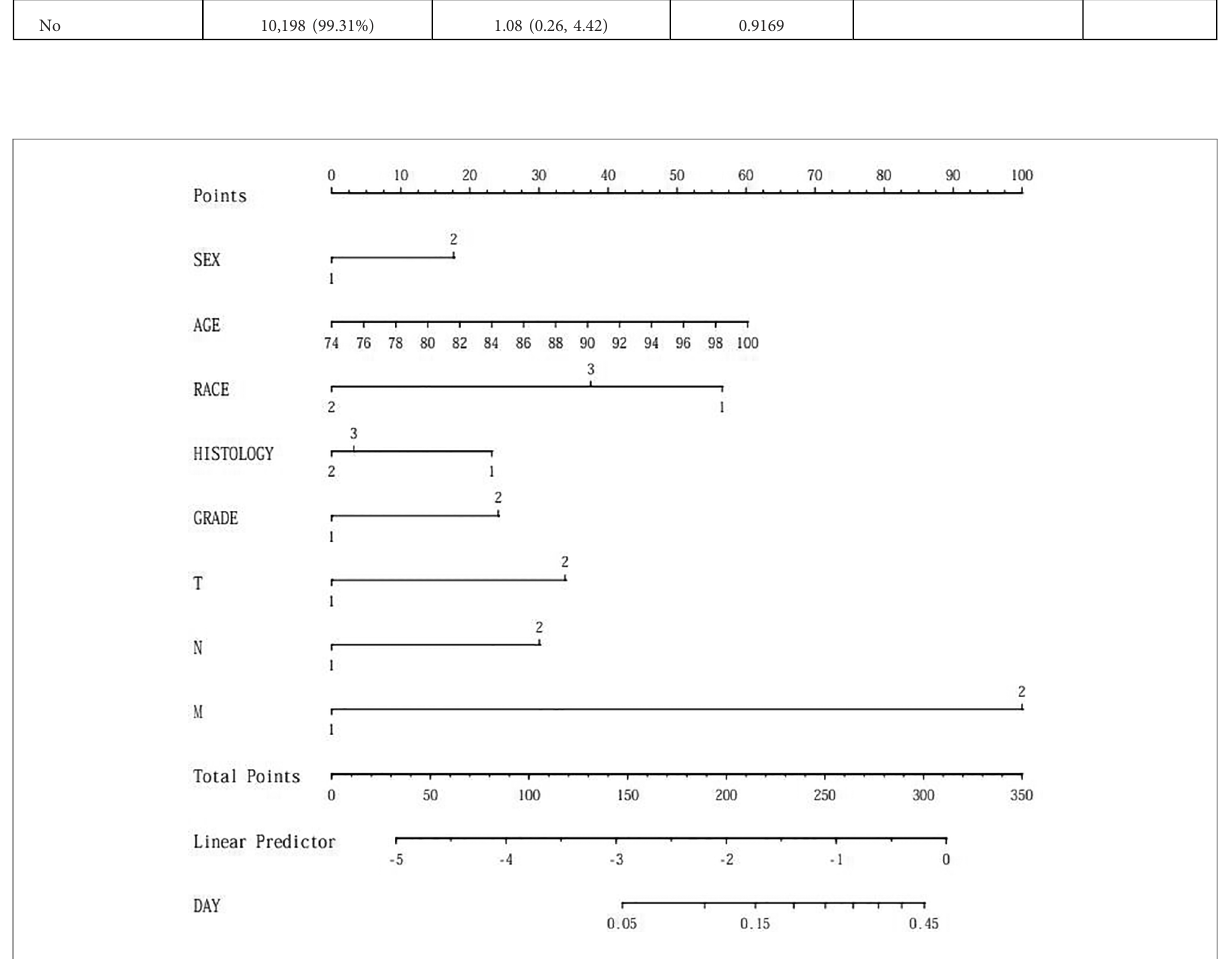
FIGURE 2 Predicted survival line graph for elderly patients undergoing lobectomy for